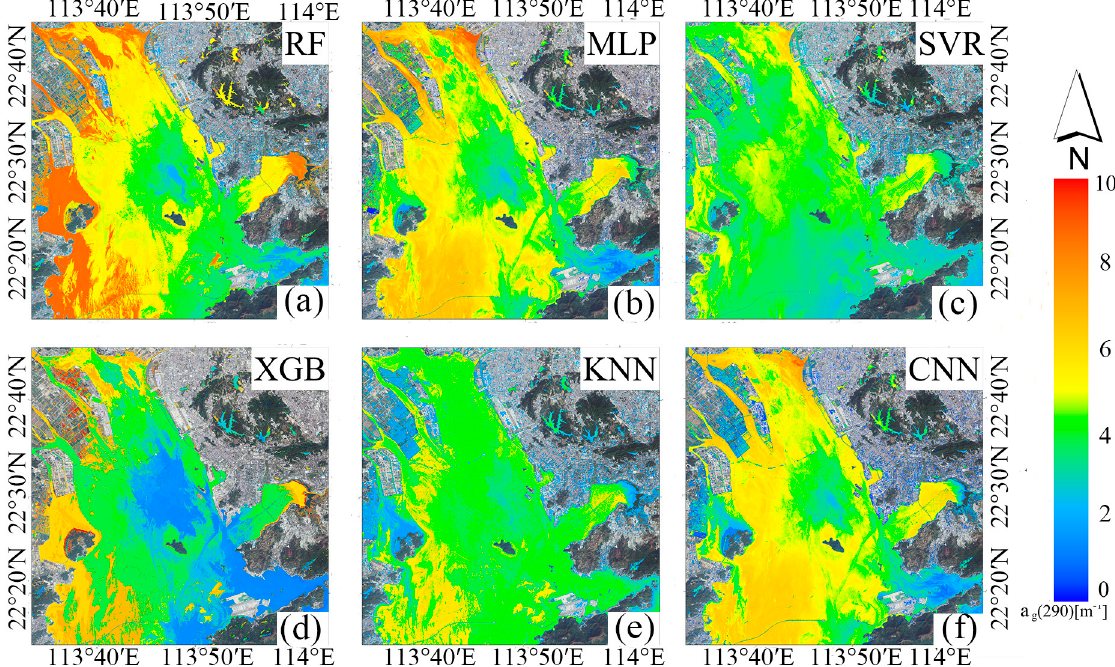
Figure 4. Estimated CDOM a g (290) based on the RF ( a ), MLP ( b ), SVR ( c ), XGB ( d ), KNN ( e ), and CNN ( f ) algorithms from the Landsat-8 OLI image data on 12 May 2021 in the CNN ( f ) algorithms from the Landsat-8 OLI image data on 12 May 2021 in the PRE.